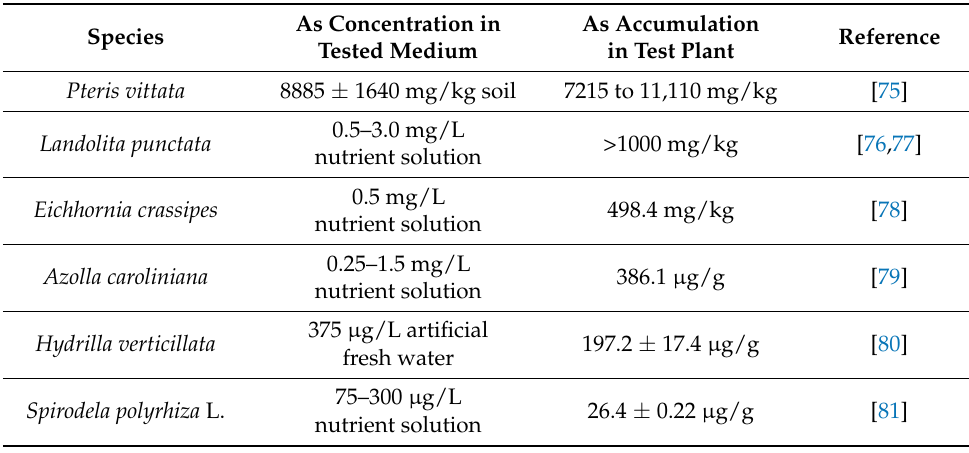
Table 2. Arsenic-hyperaccumulating plant species.